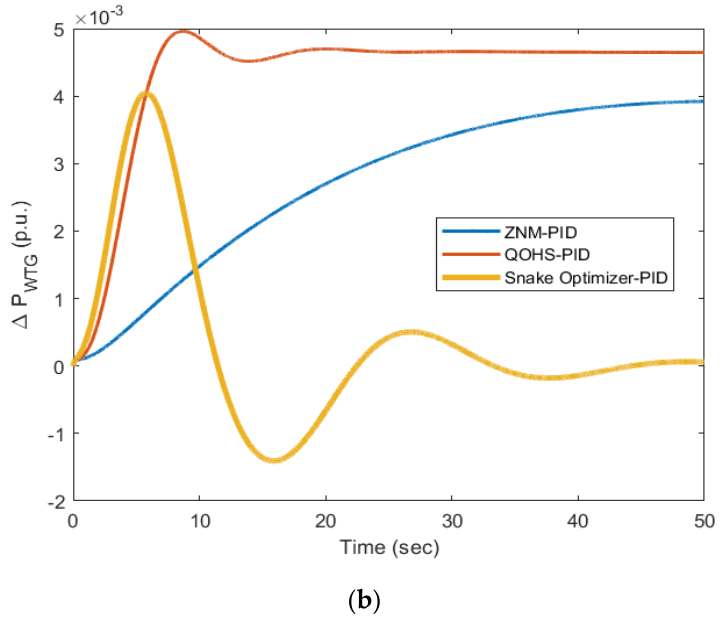
Figure 8. ( a , b ) Output of diesel–wind isolated system for 0.01 p.u. step change in wind speed.